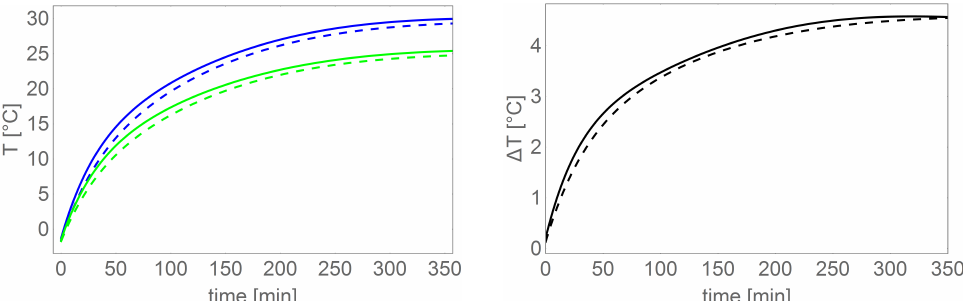
Figure 29. Left chart shows comparison of BLDC motor heating curves controlled based on an external sensor ( Te 1 dashed line, Te 2 solid line) for two power supply variants: power supply without DC/DC converter (blue color), power supply via DC/DC converter (green), right chart shows differences between the heating temperature shown in the left